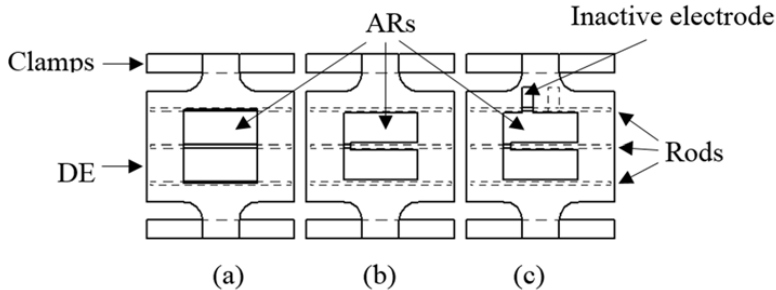
Figure 2. Configured Rod Pre-strained Dielectric Elastomer Actuators (RP-DEAs) in life assessment: ( a ) single AR; ( b ) two separate ARs connected via bridge; and ( c ) two separate ARs with bridge and extended electrode region for connection.